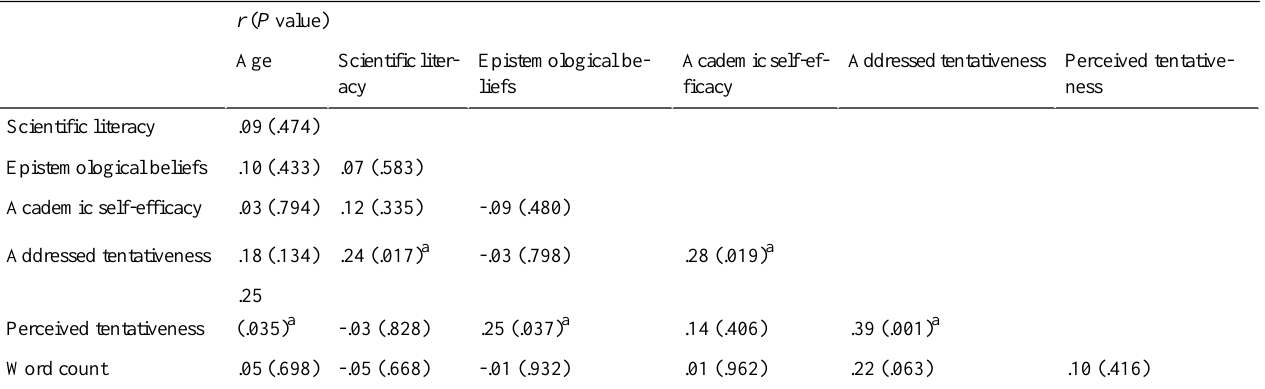
Table 4. Pearson correlations among measured